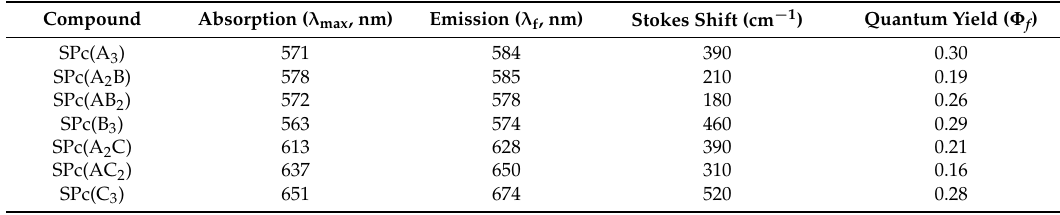
Table 2. Summary of SPc photophysical parameters 1 .